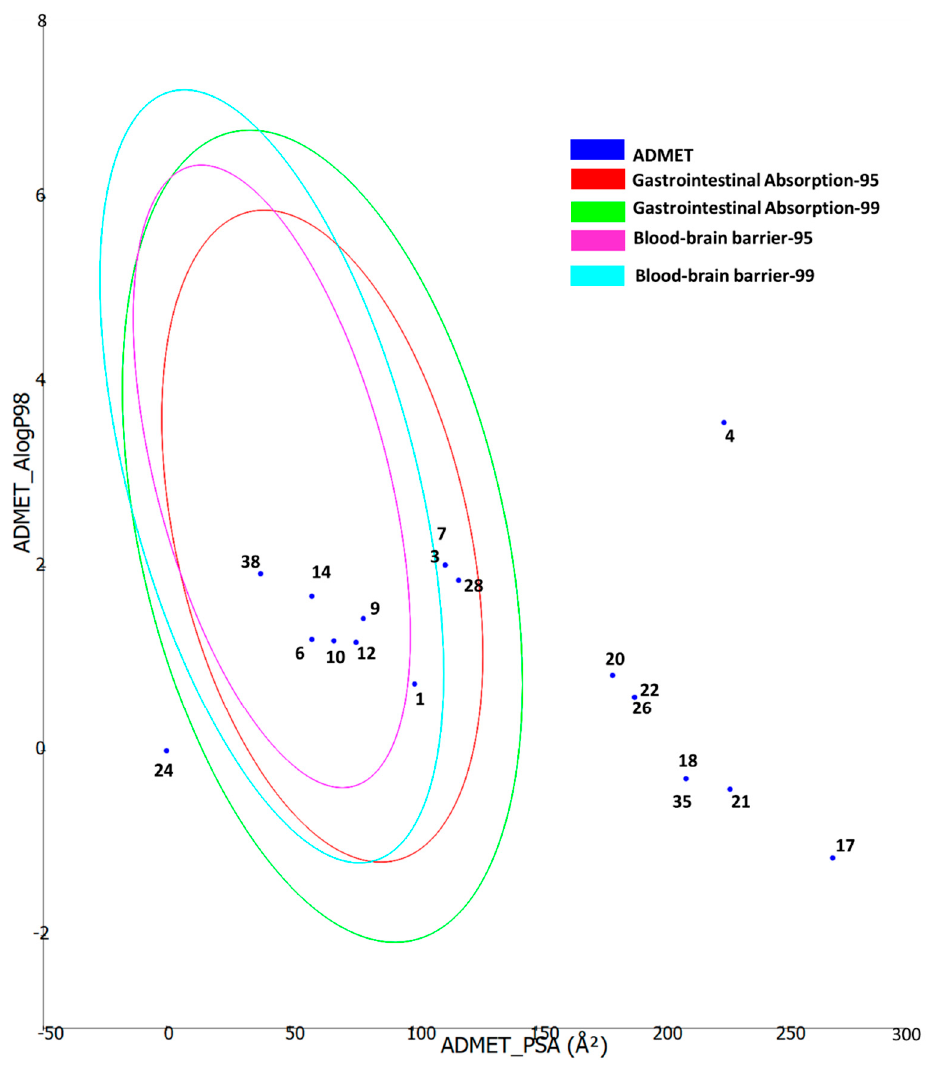
Figure 5. ADMET properties of the bioactive compounds extracted from two Cassia and two Senna species predicted using the Biovia DS ADMET prediction toolkit. The four ellipses enclose the area where well-absorbed compounds should be found: at 95 and 99% confidence levels for gastrointestinal absorption (red and green), and for blood–brain barrier penetration (magenta and aqua). The compounds are shown according to their serial number in Table 2.